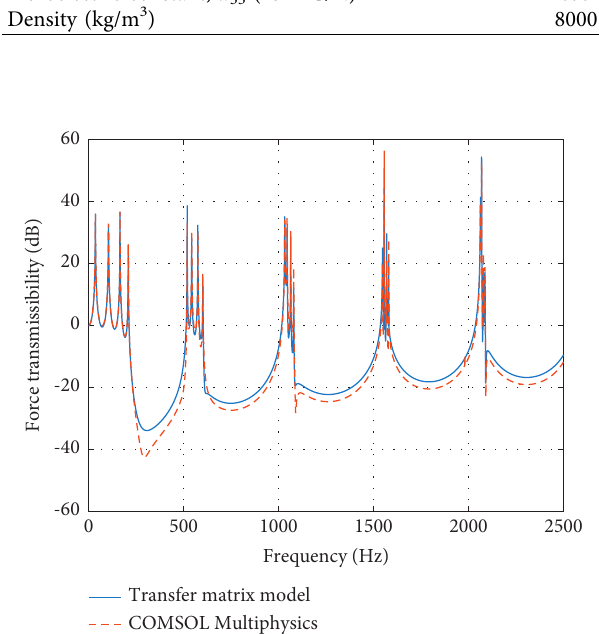
Figure 8: Frequency response of the PSPS force